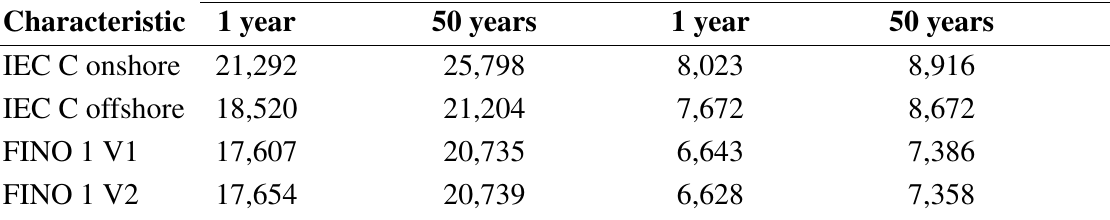
Table 2. Characteristic extreme loads calculated by means of the POT